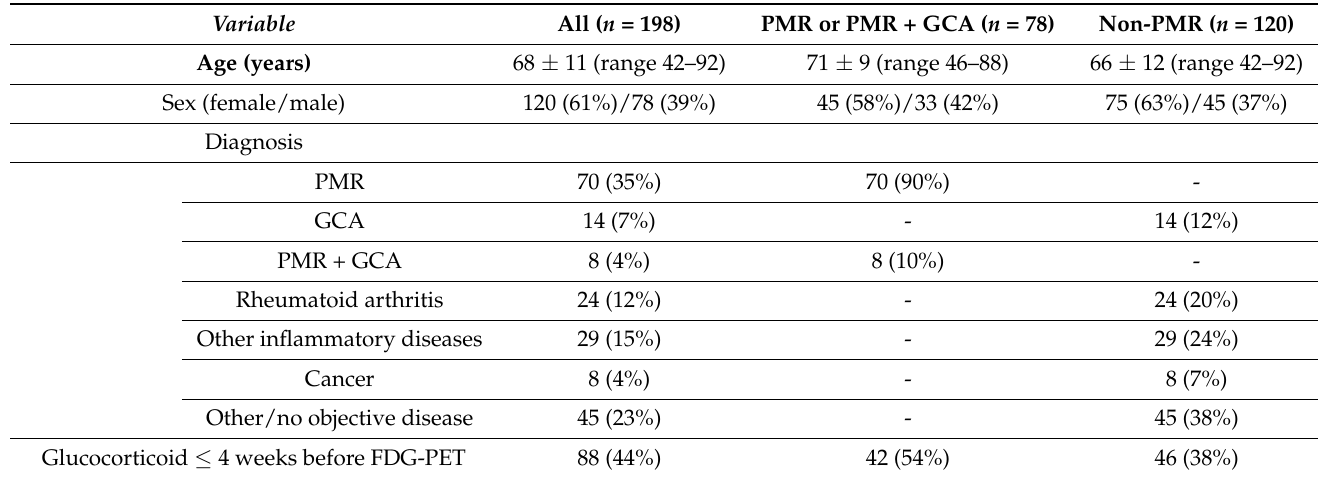
Table 1. Patient characteristics stratified by clinical diagnosis after 6